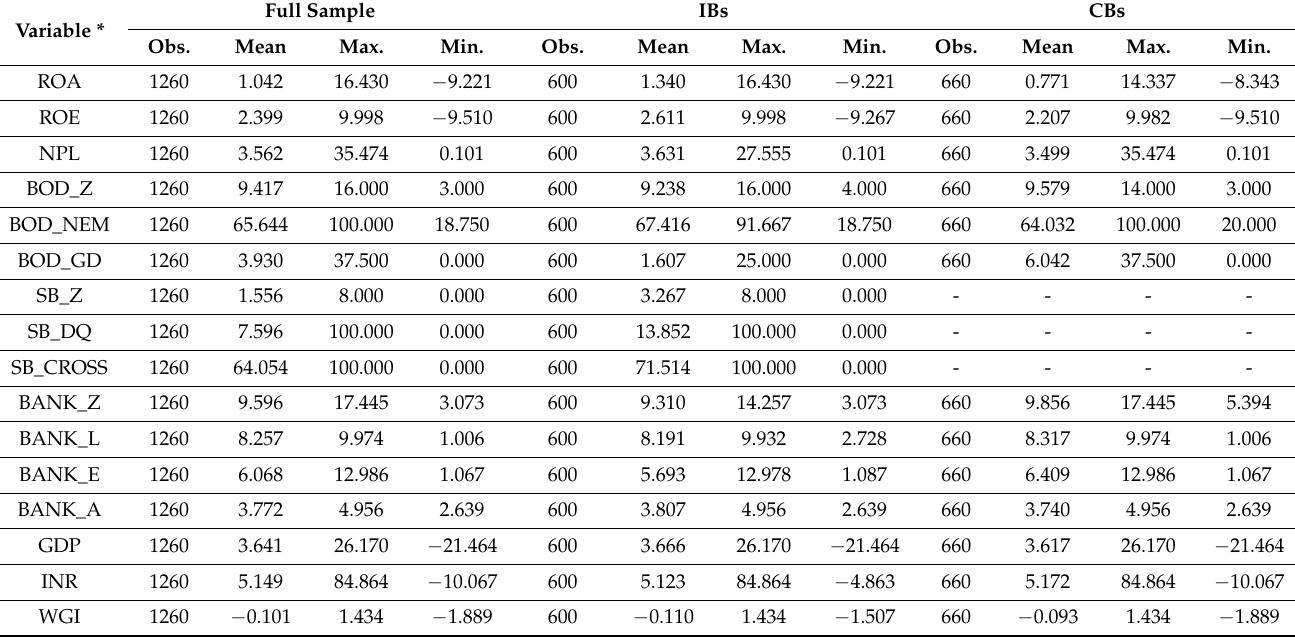
Table 4. Description of